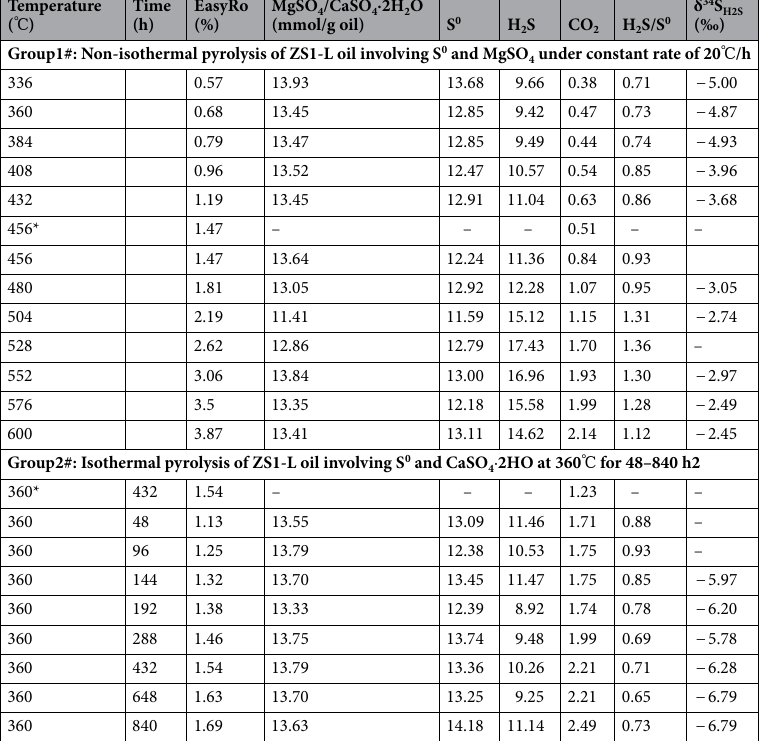
Table 2. Gas yields (mmol/g oil) and 34 S isotopic ratios of H 2 S in hydrothermal experiments involving S 0 , MgSO 4 and CaSO 4 ·2H 2 O. –Indicates not detected; *The blank experiments.